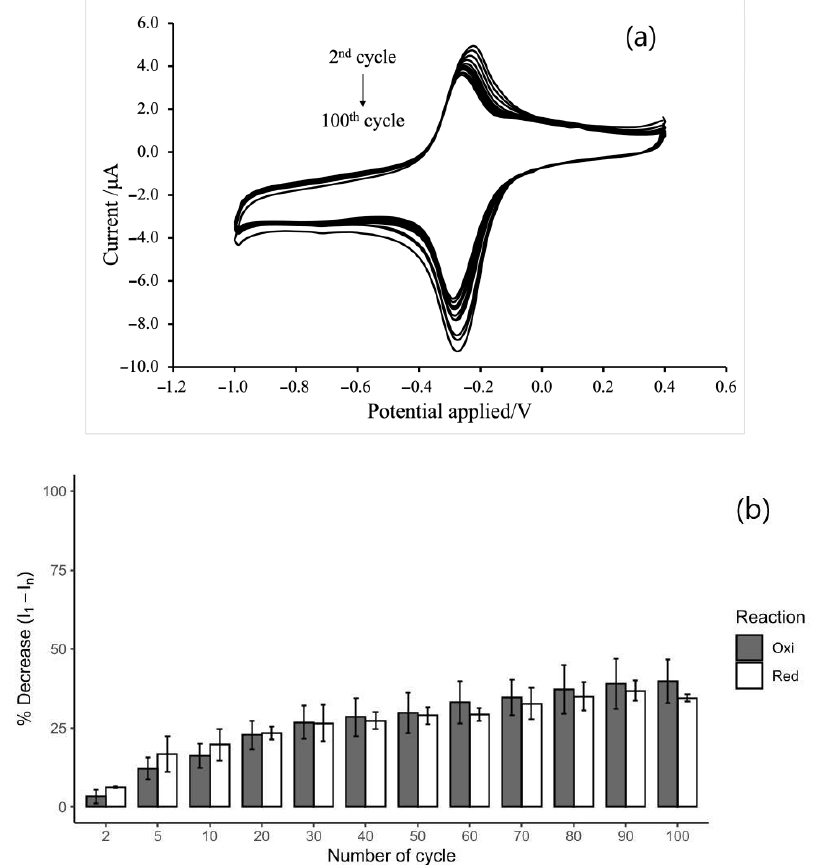
Figure 9. ( a ) Cyclic voltammograms of the MB / GB - modified electrode SPCE on scanning 100 cycles in 0 . 1 M PBS pH 7 . 0 at a scan rate of 20 mV / s . ( b ) Plots of the percentage decrease in redox current response from the initial response over n cycles ( n = 2, 5, 10, 20, 30, 40, 50, 60, 70, 80, 90, 100